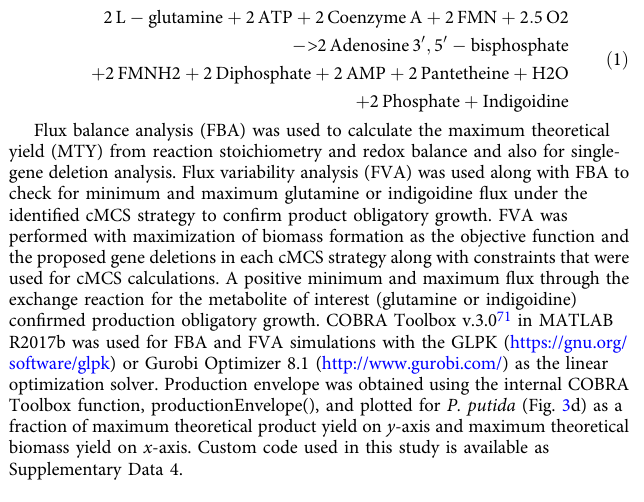
plementary Table 8. Speci fi c DNA sequences used to design the gRNA array are described in Supplementary Data 1. All primers used in this study are listed in Supplementary Table 9. Electroporation with the respective plasmid was performed using a Bio-Rad (Bio-Rad Laboratories, Hercules, CA) MicroPulser pre- programmed EC2 setting (0.2 cm cuvettes with 100µL cells, ~5 ms pulse and 2.5 kV) with slight modi fi cations 73 . Cells transformed with replicative plasmid DNA were allowed to recover at 25°C for 2.5h before plating on selective agar media at 23 ˚ C for overnight incubation. Cells transformed with non-replicative